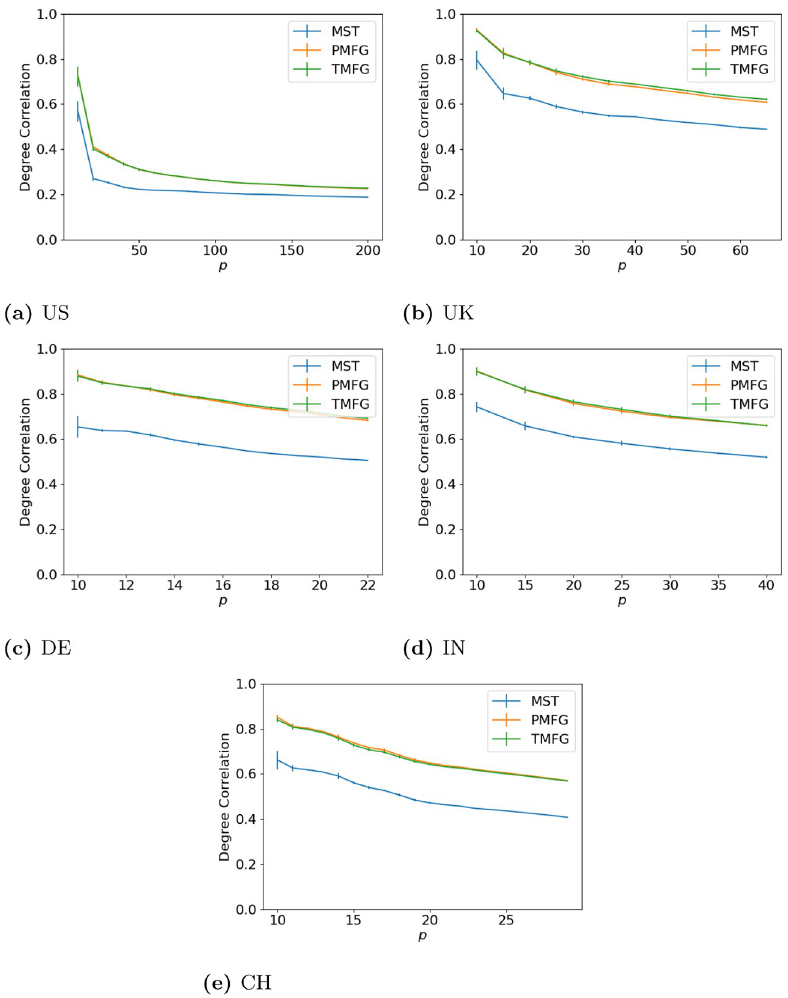
Fig 2. Degree agreement between the full and filtered correlation matrices with different values of p for the windows with maximum volatility. ( a ) US, ( b ) UK, ( c ) DE, ( d ) IN, ( e ) CH.